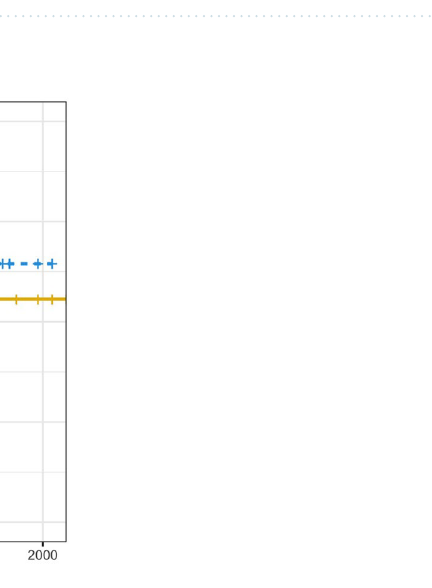
Figure 4. Nomogram of the combined model for predicting the risk of high pathological grade.